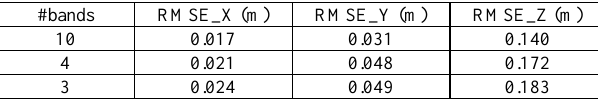
Table 4. Simulated data: discrepancies in seven check points considering variations of the number of bands and 28 GCPs.